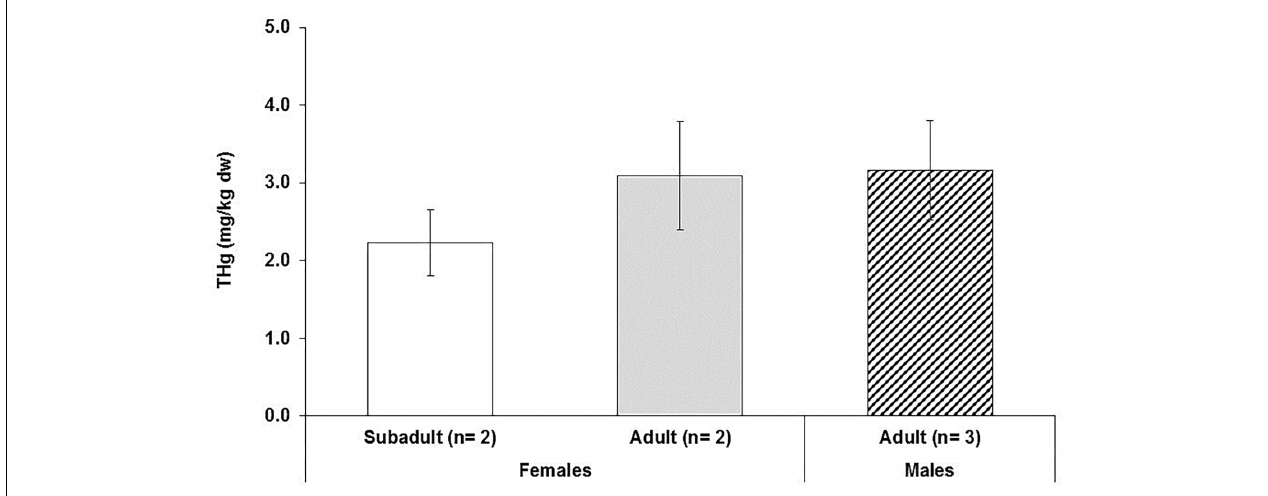
FIGURE 5 | Total mercury (THg) concentrations (mg/kg dry weight) detected in skin of free ranging bottlenose dolphins. The mean ± SD of THg concentrations (mg/kg dw) is shown for adult males and females and subadult females. No significant differences were found between adult age categories of males and females.